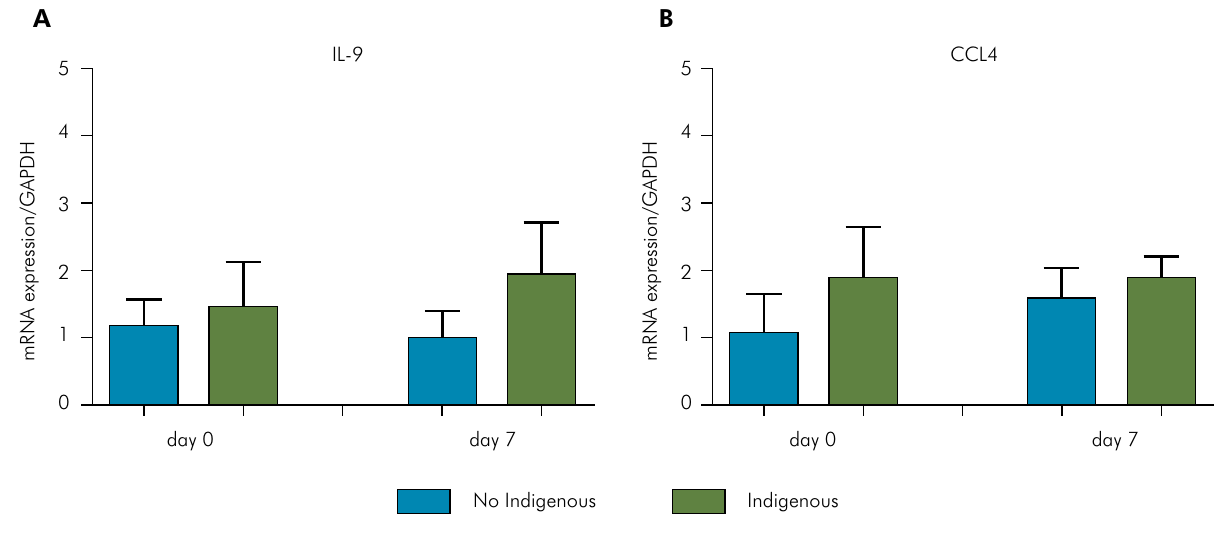
Figure 3 (a, b). Expression of IL-9 and CCL4 genes in the periradicular tissues of indigenous and urban individuals with root canal infections. Levels of expression were determined by real-time PCR and quantified by comparison with an internal control (GAPDH). Bars represent the mean values of samples recovered from teeth that did or did not receive endodontic treatment; lines represent the standard error of the mean. *p < 0.05 by Wilcoxon or Mann–Whitney